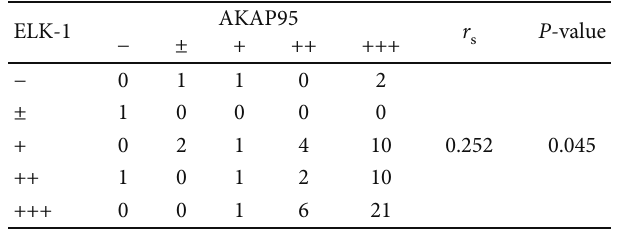
Table 4: The relationship between AKAP95 and ELK-1 protein expression in colon cancer tissue.